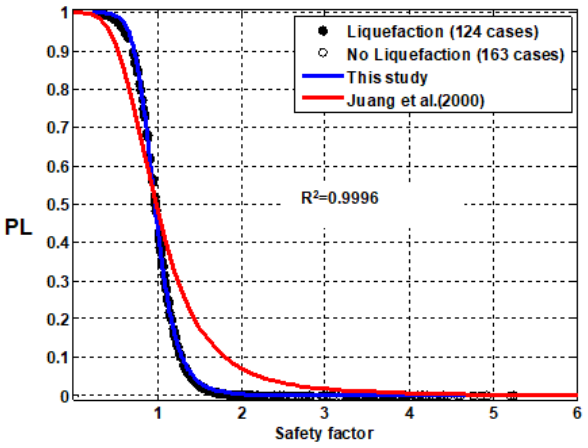
and Fs based on Bayesian L